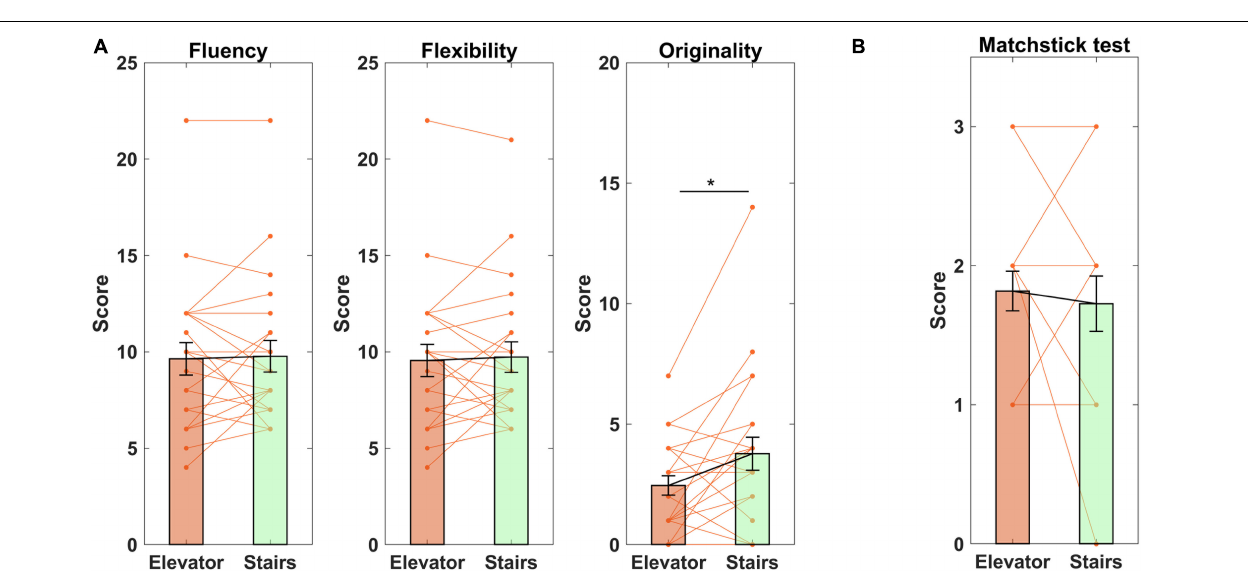
FIGURE 3 | Intervention effect on divergent and convergent thinking. (A) Alternate Uses Test; (B) , Matchstick test. * p < 0.05. Data shown as mean ±